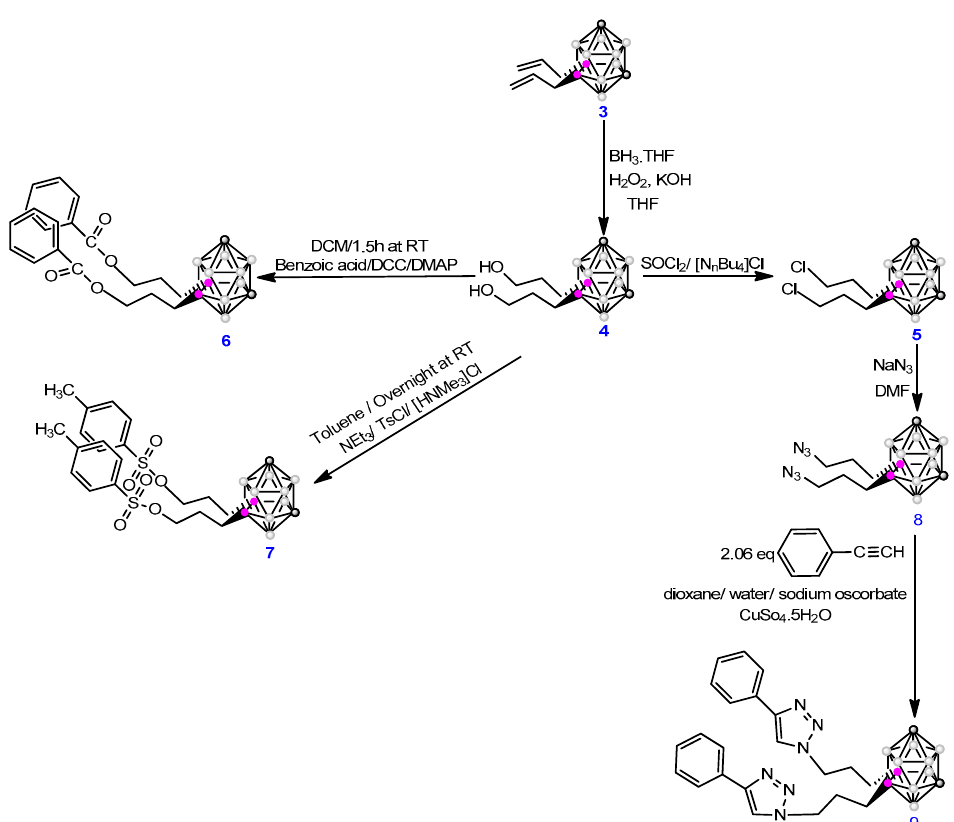
vertexes, pink circles are boron atoms, and grey circles are B-H